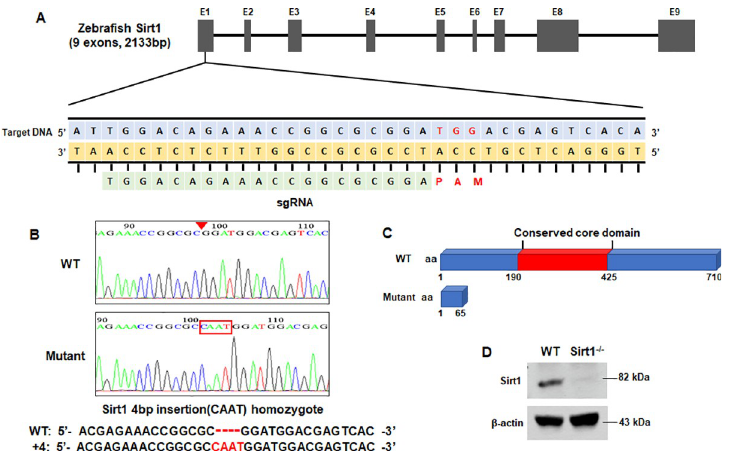
Fig 1. Sirt1 Knockout by Crispr/Cas9 technique. (A) Schematic illustration of the Sirt1 locus. Exon 1 of the Sirt1 gene was targeted. The CRISPR target site and PAM motif are indicated. (B) Sequence confirmation of four-nucleotide insertion mutations. (C) Predicted truncation of the SIRT1 protein. (D) Expression of the Sirt1 mutant was verified by western blot using an antibody of Sirt1 ; β -actin was used as a loading control.